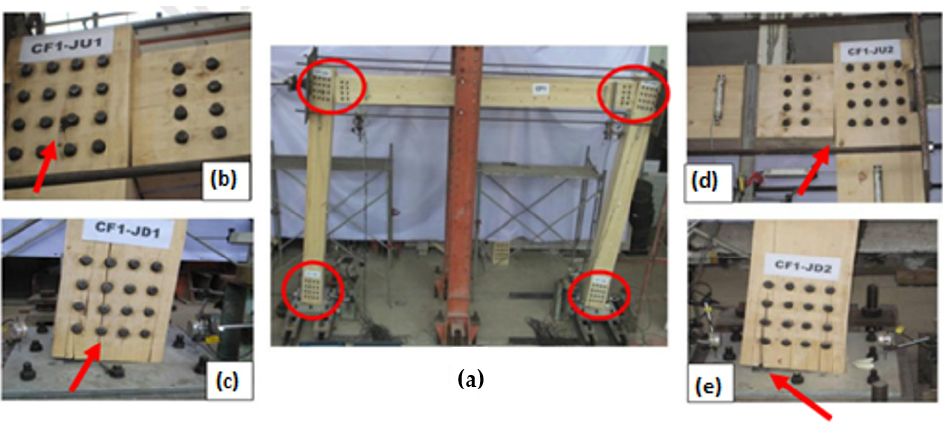
Figure 2. ( a ) Deformation of frame structure; ( b ) left beam–column joint; ( c ) left column–base joint; ( d ) right beam–column joint; ( e ) right column–base joint; adapted from [20]. ( d ) right beam–column joint; ( e ) right column–base joint; (adapted from